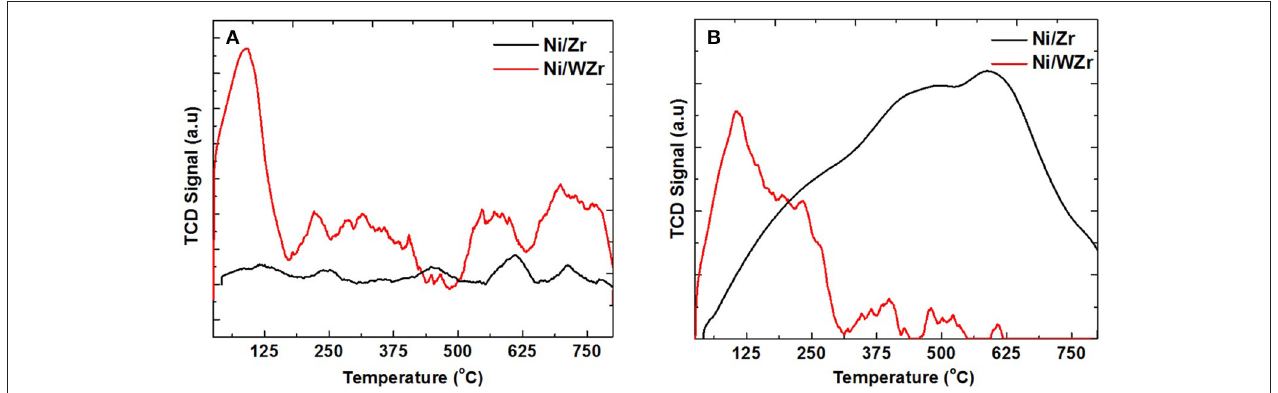
FIGURE 3 | (A) NH 3 -TPD and (B) CO 2 -TPD, for both Ni/Zr and Ni/WZr catalysts (Catalyst mass: 0.15 g, Gas mixture: 5 vol % CO 2 /Ar and 1 vol.% NH 3 /He, Gas flow rate: 30 NmL/min, Temperature ramp of 30 ◦